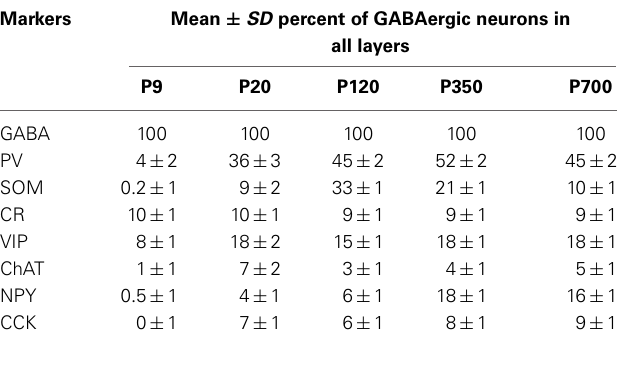
Table 1 | Relative percentage of the interneuron markers examined in A1 at different ages.